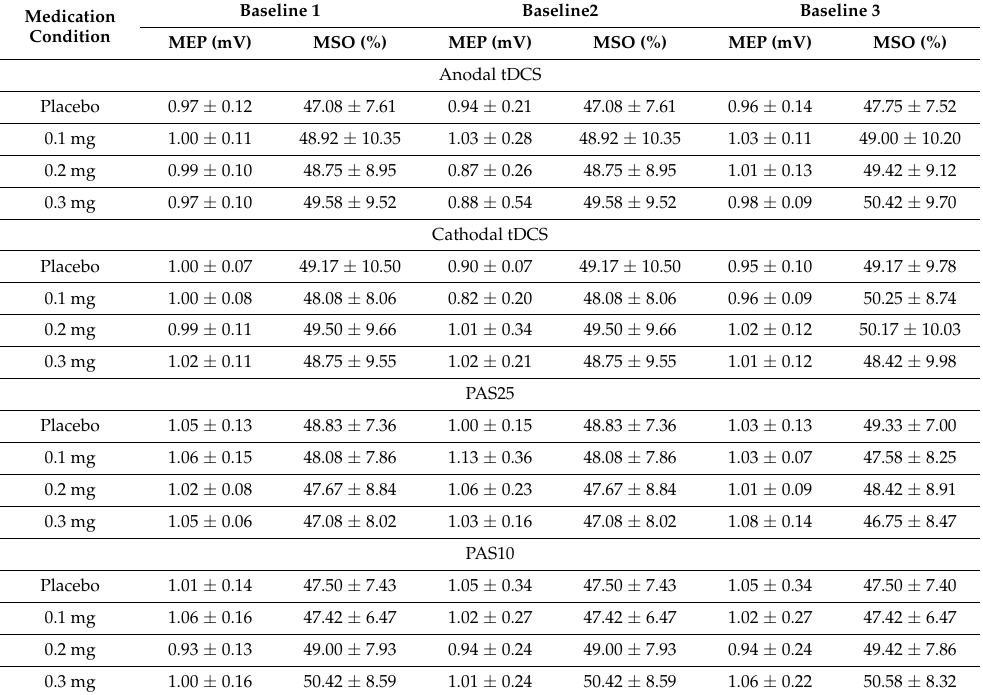
Table 1. Prestimulation peak-to-peak MEP amplitude and TMS intensity before and after application of